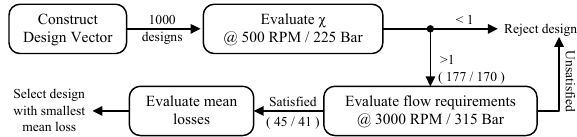
Figure 8: Pump selection algorithm. In